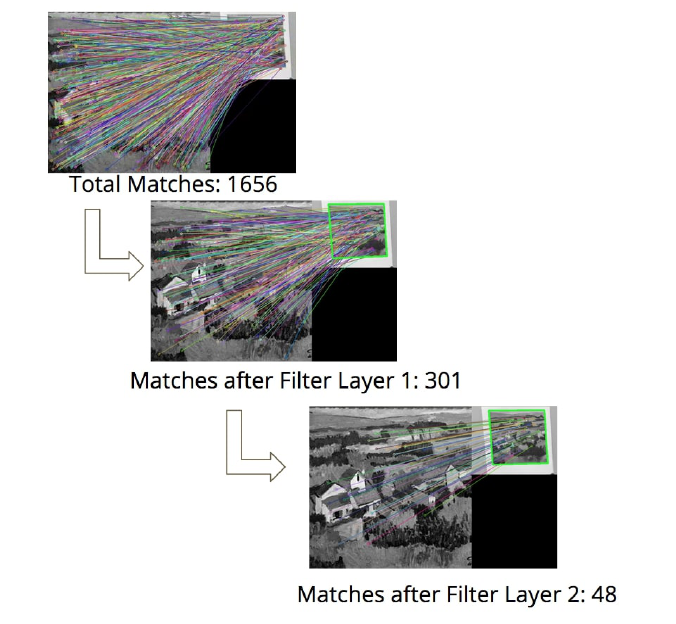
Figure 11. Matching